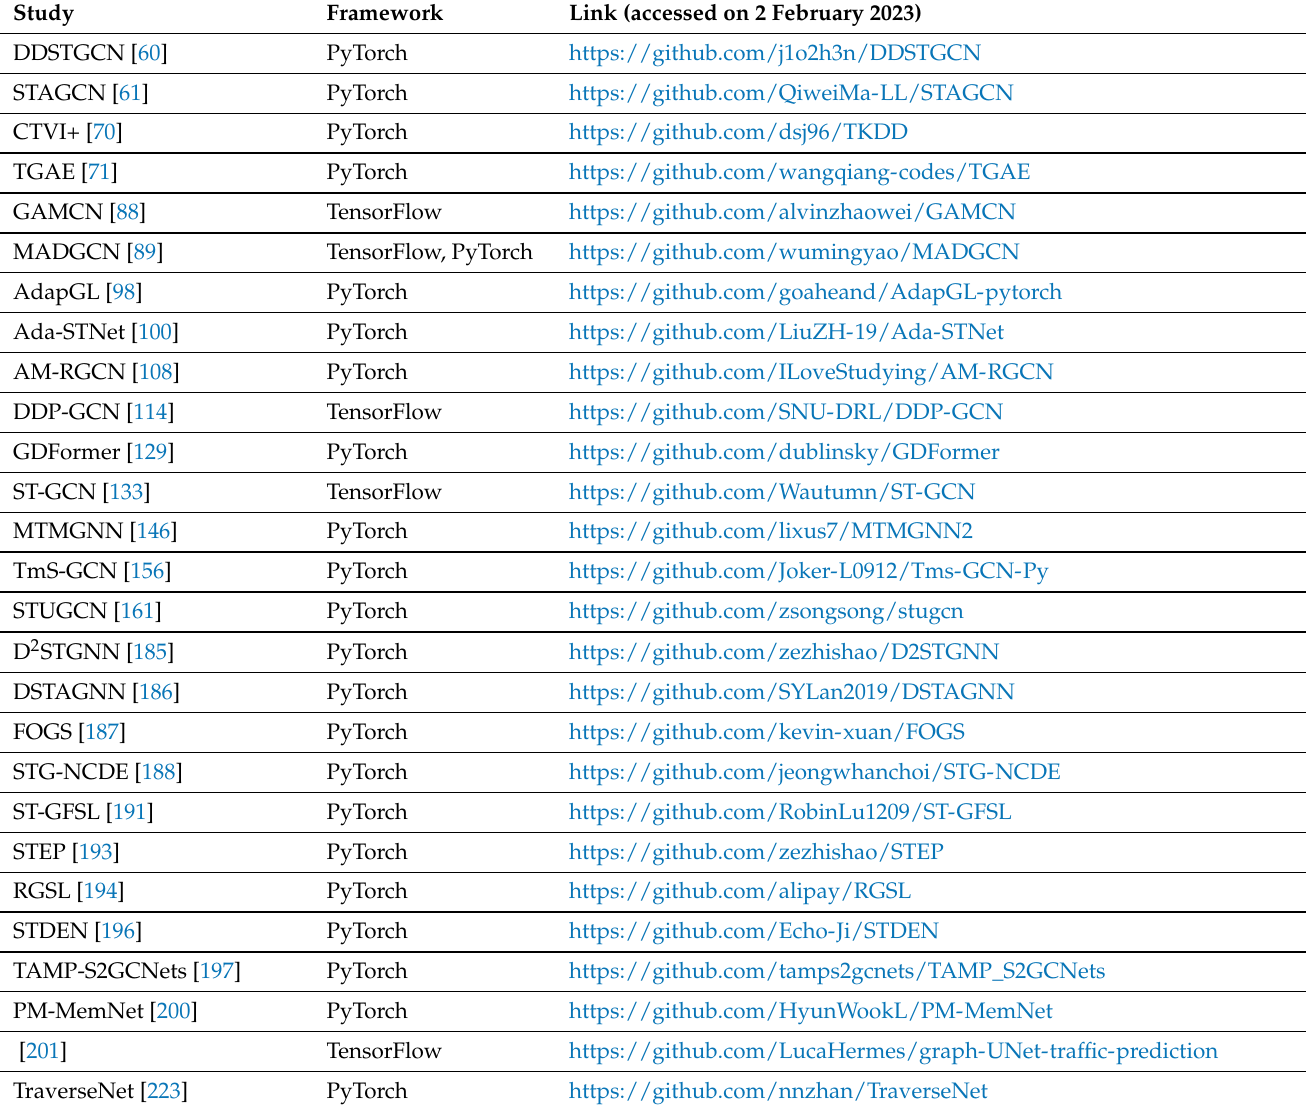
Table 3. The list of new open-code